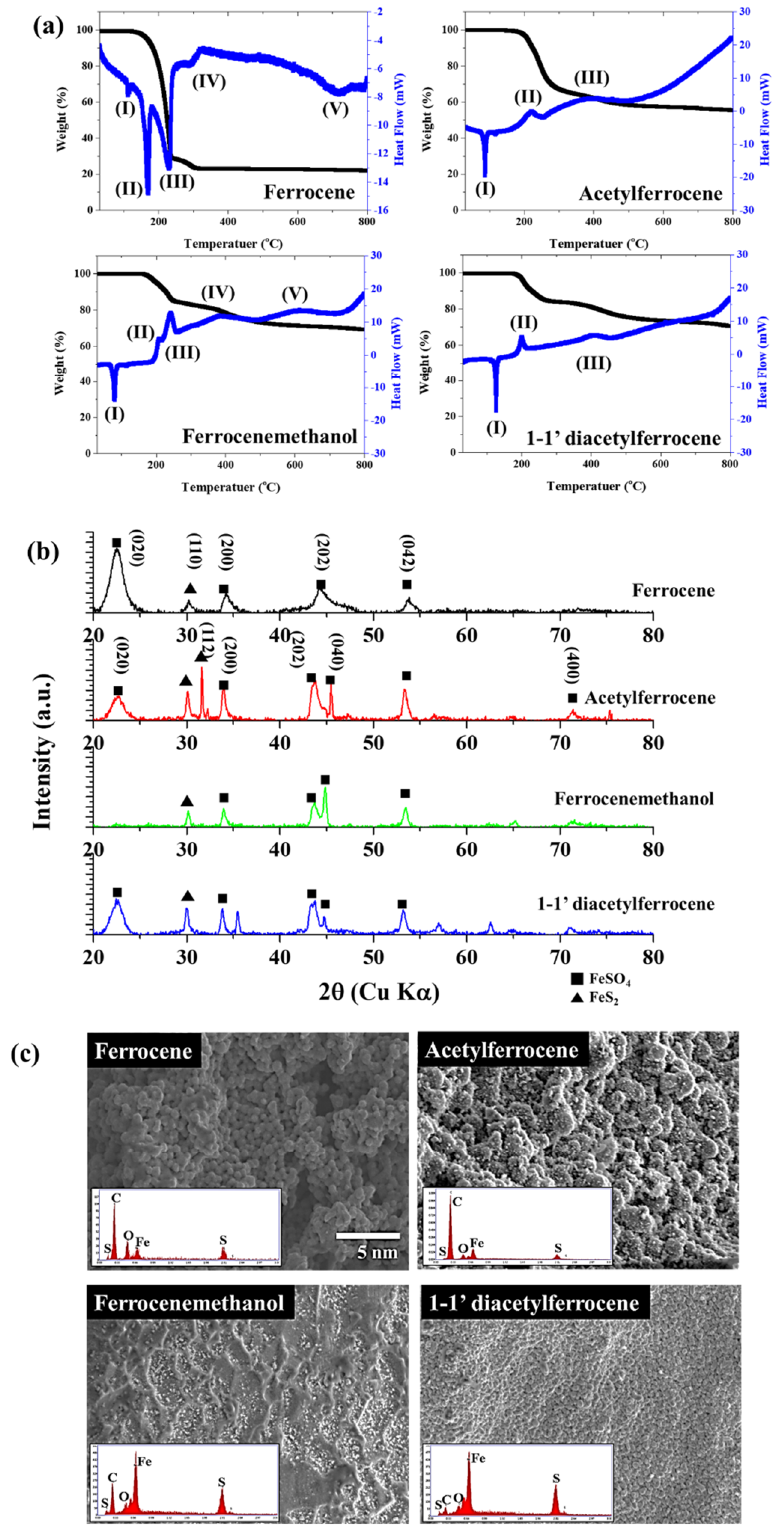
Figure 7. ( a )TG-DSC about catalyst precursors with sulfur, ( b ) XRD patterns, and ( c ) SEM images and EDS about catalyst precursors with sulfur after thermal